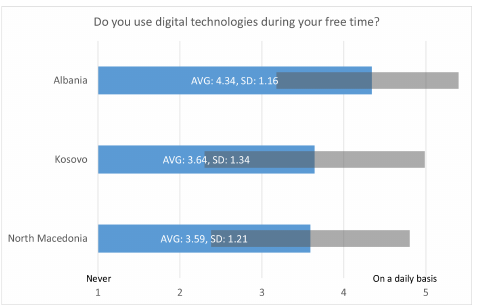
Figure 14. Frequency of usage of dedicated laboratories in